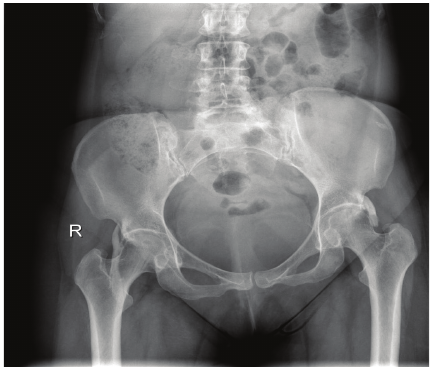
Figure 1: Anteroposterior X-ray of the pelvis at the initial presenta- tion.